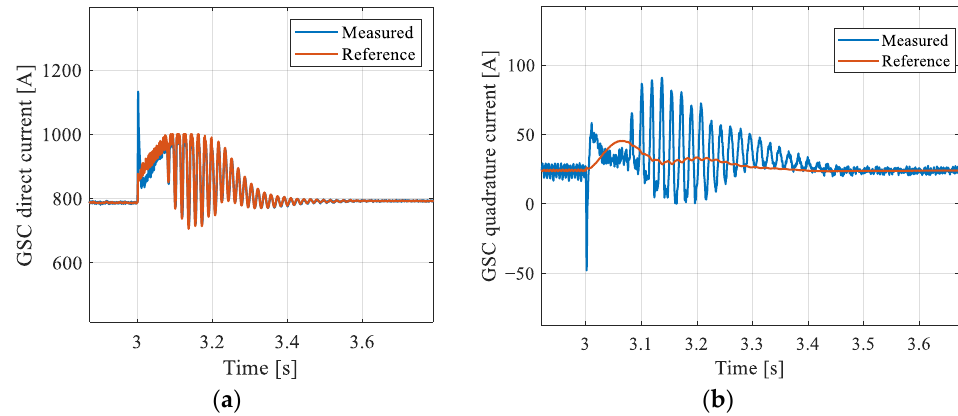
Figure 9. GSC currents: ( a ) d axis component and ( b ) q axis component.